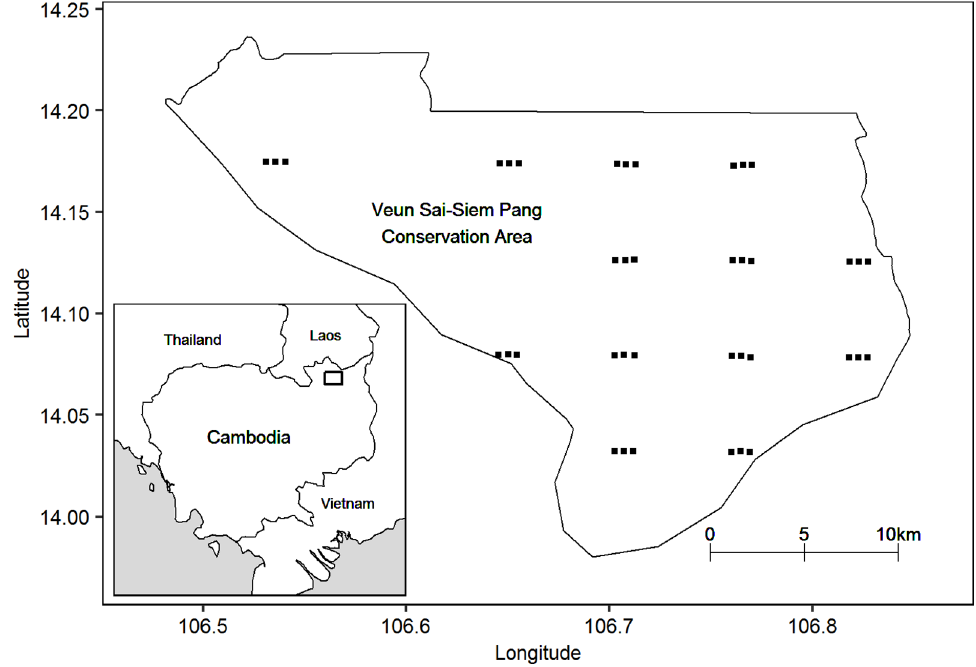
Fig 1. Listening post locations. Each of the 13 detector arrays for the case study survey consisted of a linear arrangement of three listening posts spaced 500m apart.